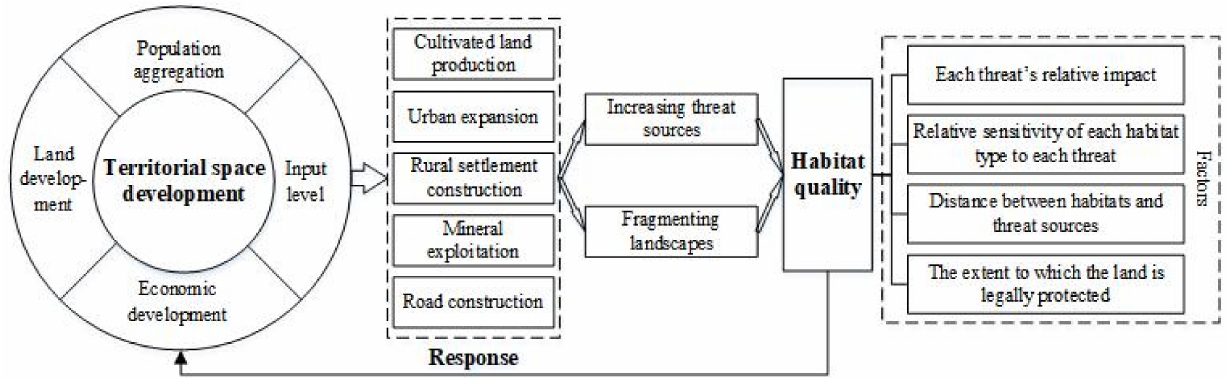
Figure 1. Mechanism of the HQ response to